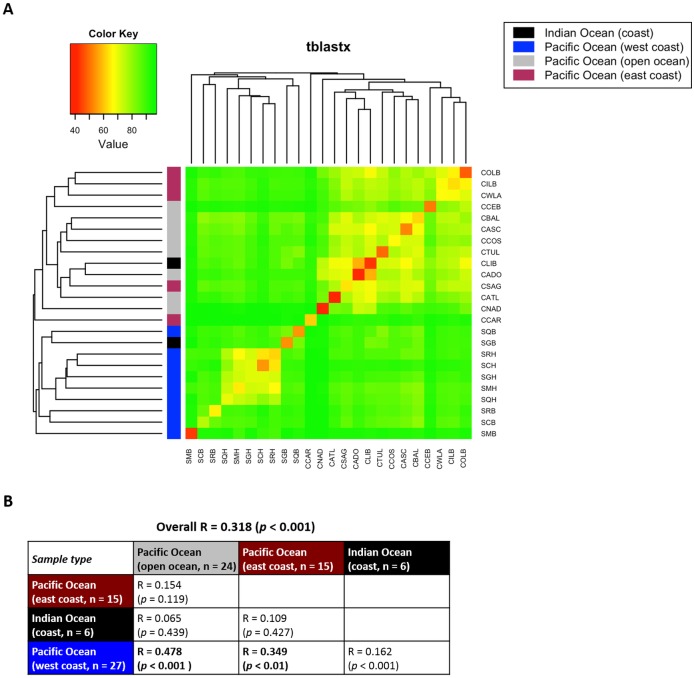
Influence of geography on virome composition.72 virome data sets were compared with each other based on sequence similarity using TBLASTX comparison. (A) Heatmap presenting the difference in the virome composition. A hierarchical cluster analysis was performed using the complete linkage algorithm. (B) Analysis of similarity result to identify the difference in the virome composition. Bold text indicates a significant difference between ocean viromes.